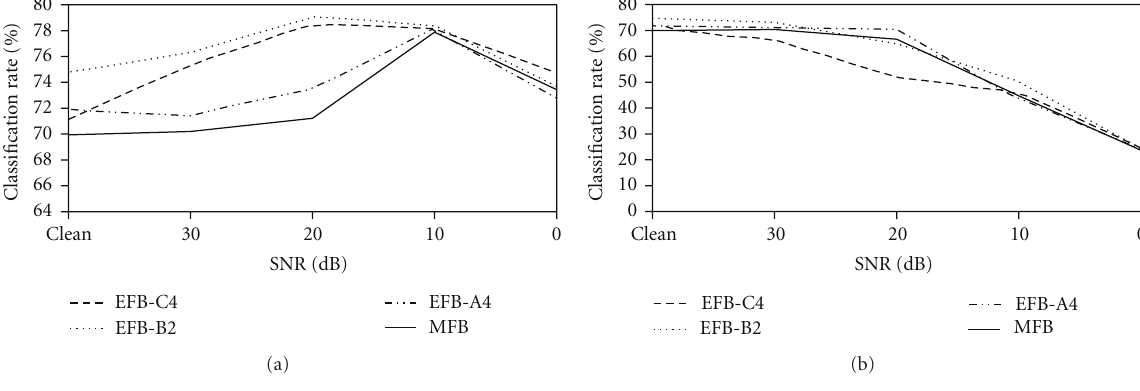
Figure 8: Averaged validation results for phoneme classification comparing MFB with EFB-A4, EFB-B2, and EFB-C4 at di ff erent training conditions. (a) Validation in match training conditions, and (b) validation in mismatch training